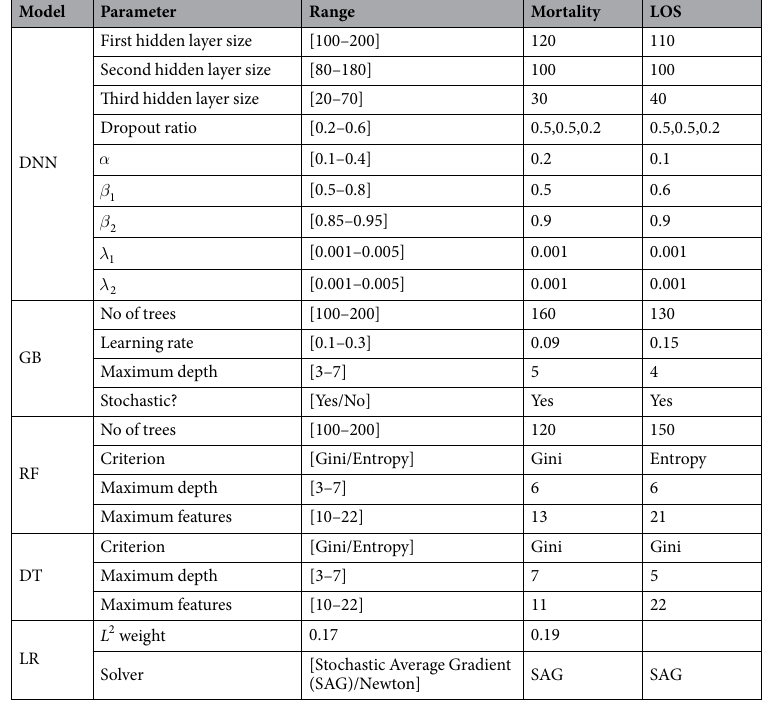
Table 2. Optimal parameters of the developed models based on the Bayesian optimization technique. The network size is the number of neurons in each layer. Dropout technique only applies to the hidden